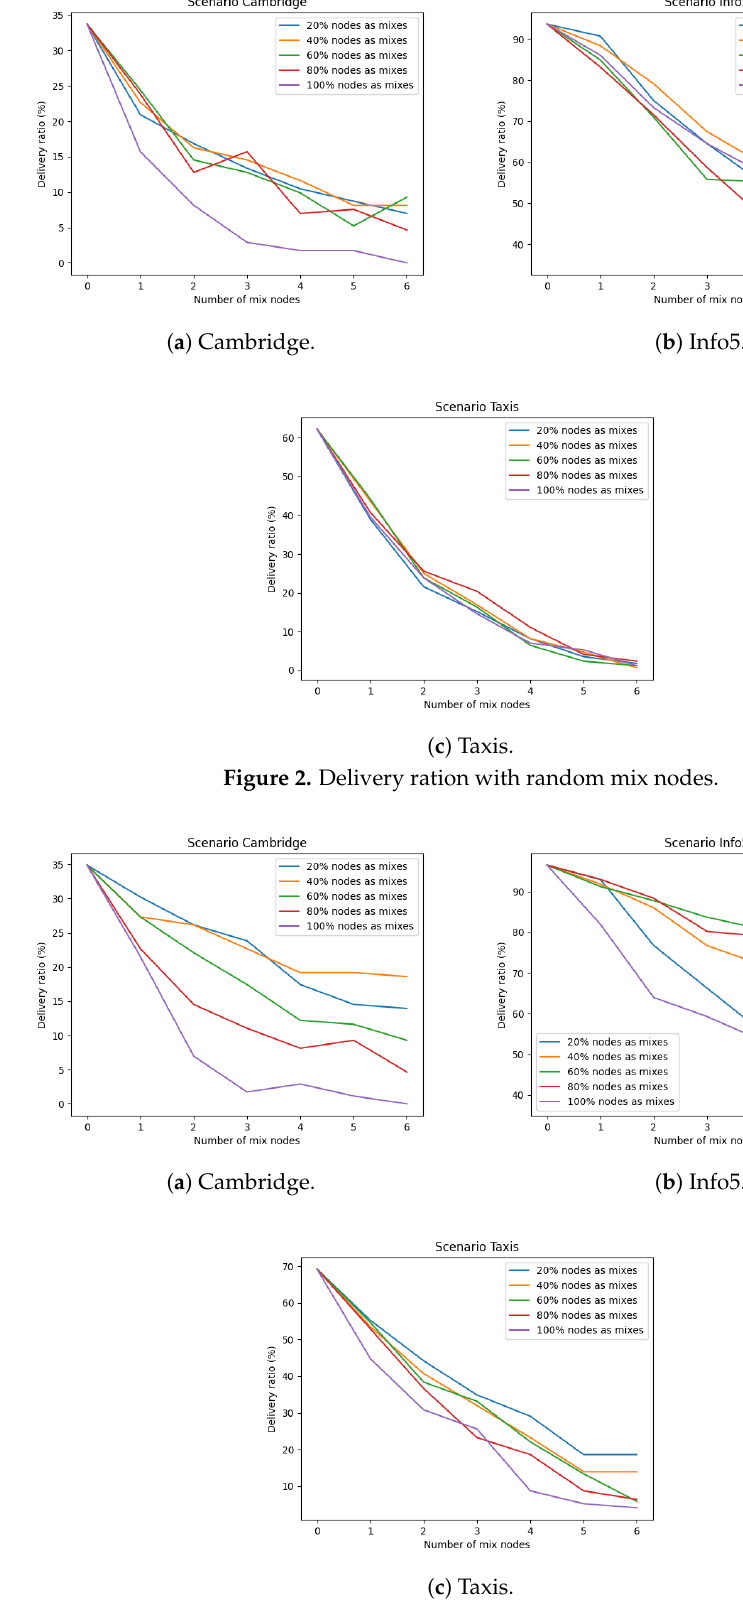
Figure 3. Delivery ratio with centrality mix